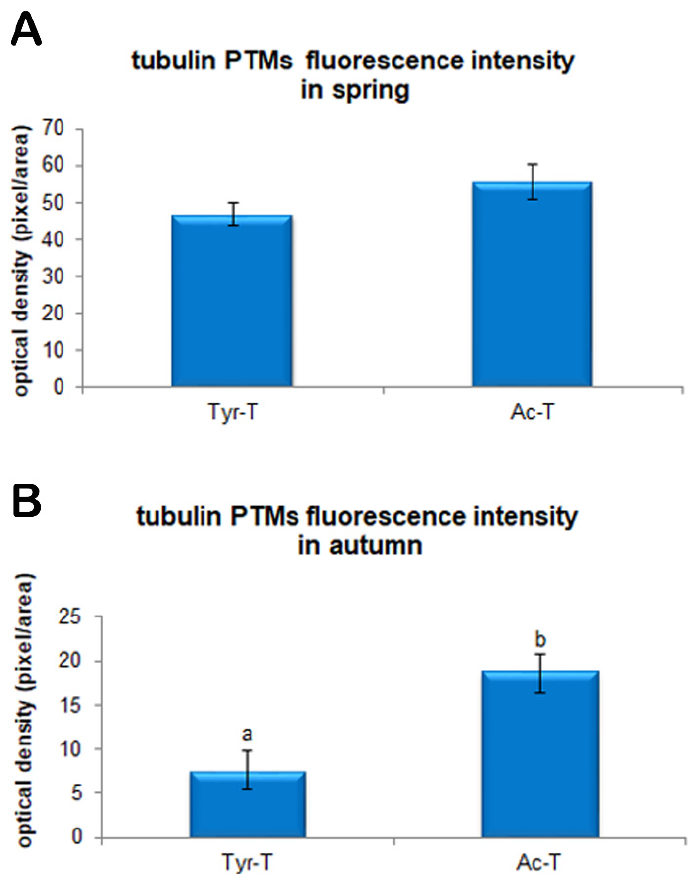
Figure 3. Quantification of fluorescence intensity for tyrosinated and acetylated α -tubulin in MII prepubertal ovine oocyte collected in autumn ( A ) and spring ( B ). Values are expressed as arbitrary units (Mean ± mean standard error). Different lower-case letters indicate statistical difference between tyrosinated and acetylated α -tubulin fluorescence intensity in autumn ( A ) and spring ( B ) metaphase II prepubertal ovine oocytes ( p < 0.01 ANOVA).